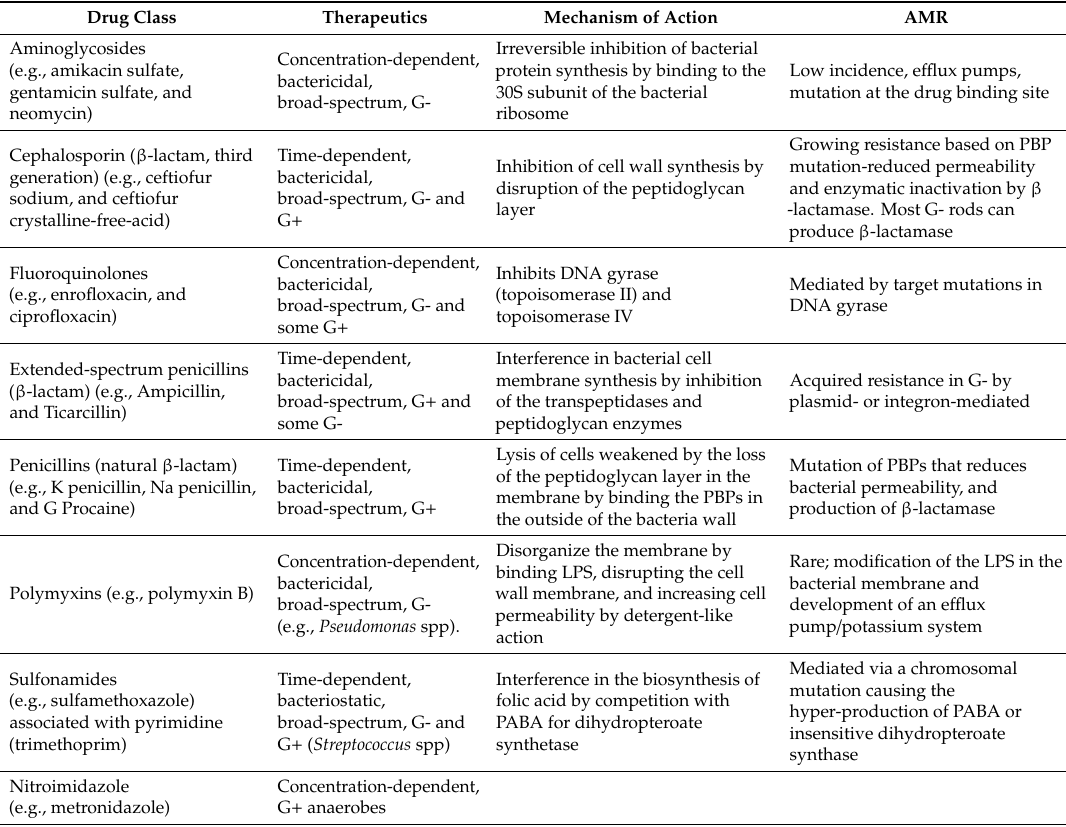
Table 3. Common antimicrobials used to treat mares su ff ering from bacterial endometritis. Drug Class Therapeutics Mechanism of